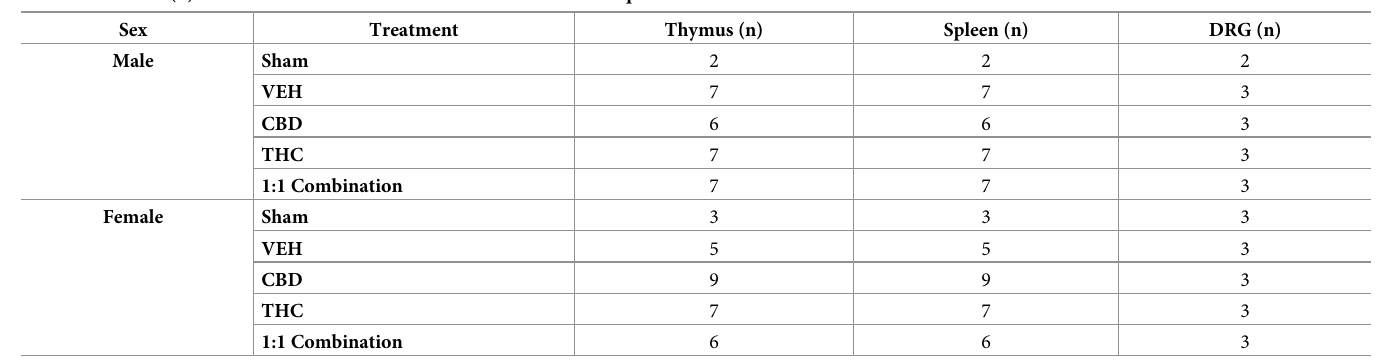
(BioRad) and rat-specific primers listed in Table 2. The integrity of each product was verified by size using agarose gel electrophoresis coupled with an examination of the specific melt peak. Relative mRNA levels were calculated using the 2-delta delta Ct method [53] following primer validation. L3-L6 pooled DRG. At endpoint, the spinal cord of each rat was carefully dissected, immediately submerged into excess RNALater solution (Ambion), and stored at -20˚C for one week. DRG associated with L3-L6 on the right side of the animal, each innervated by afferents from the cuff-bearing sciatic nerve, were carefully excised under a stereoscope. L3-L6 DRG were pooled for individual rats and RNA was extracted through mechanical homogenization in lysis buffer and purified using the Nucleospin RNA XS kit (Macherey-Nagel). The total number of DRG isolated from individual male and female rats per treatment group that were analyzed at the mRNA level is summarized in Table 1. RT-qPCR was then carried out as described.